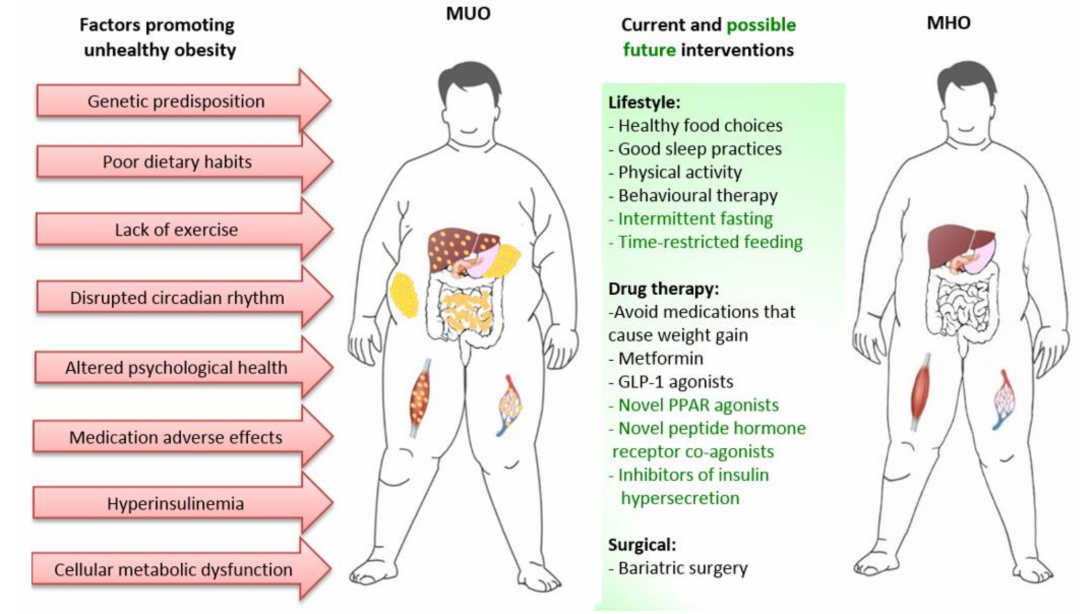
Figure 3. Figure 3 . Current and possible future interventions to prevent and reverse transition of MHO to MUO. Several factors are involved in the development of metabolic unhealthy obesity (left